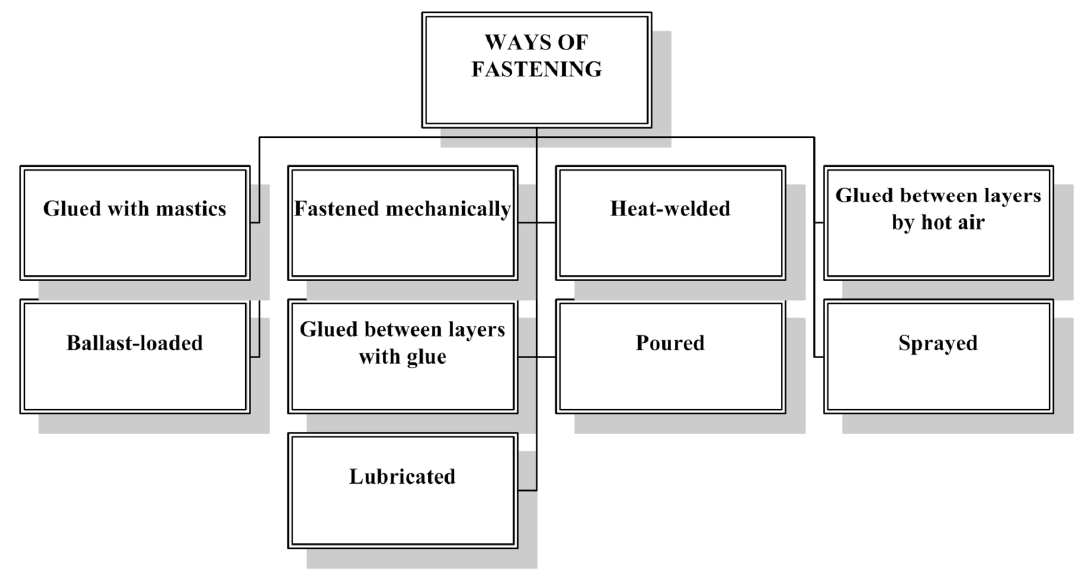
Fig. 4. Classification of waterproofing coatings by way of